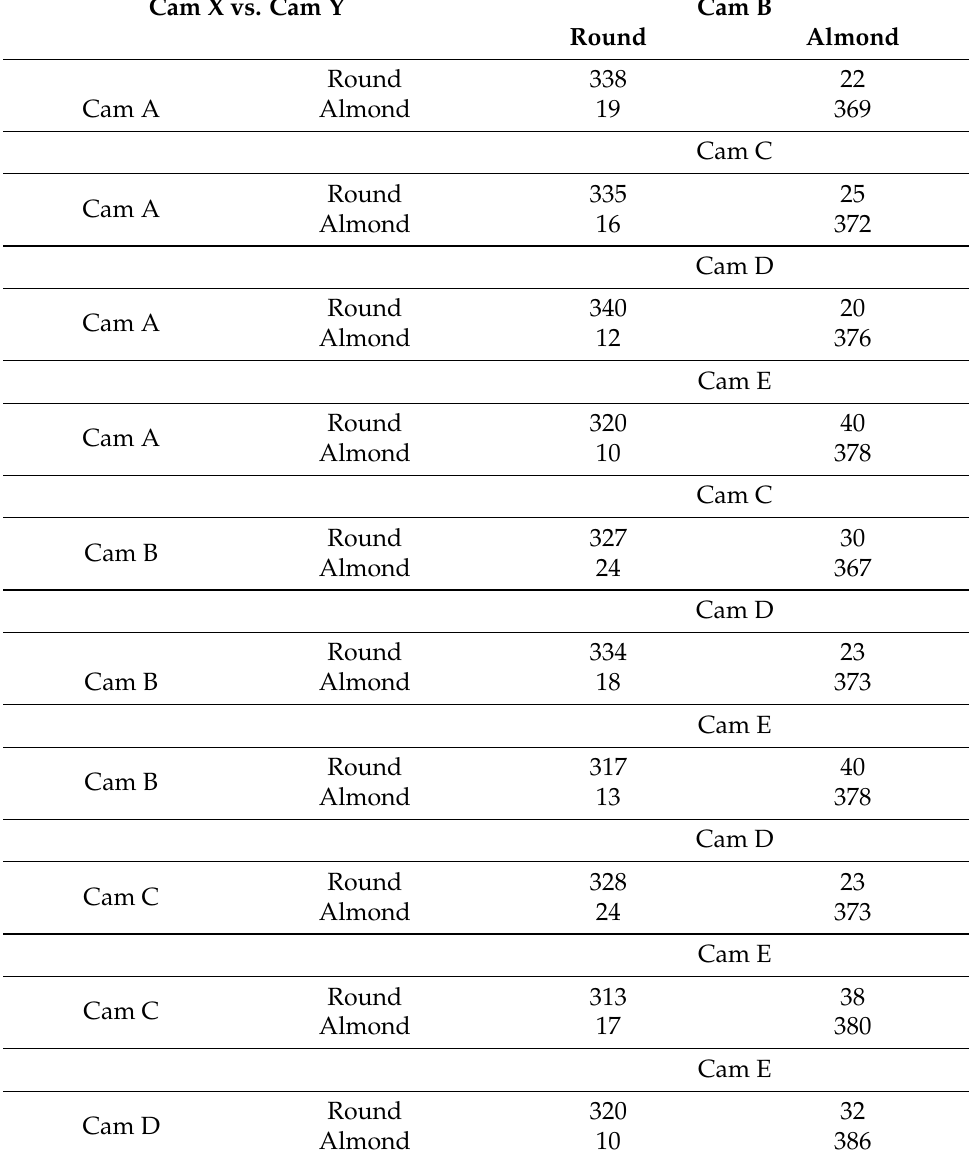
Table A6. Confusion matrices depict eye shape attributes prediction in each individual camera versus another